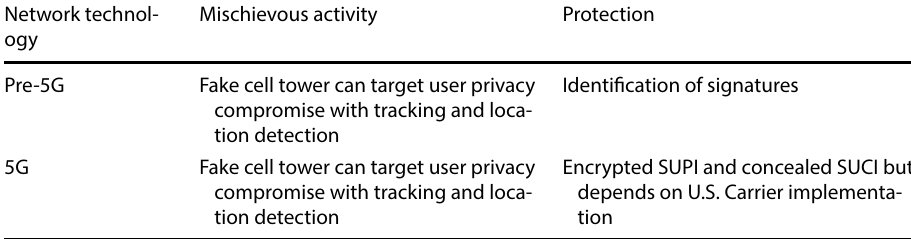
Table 10 Business control